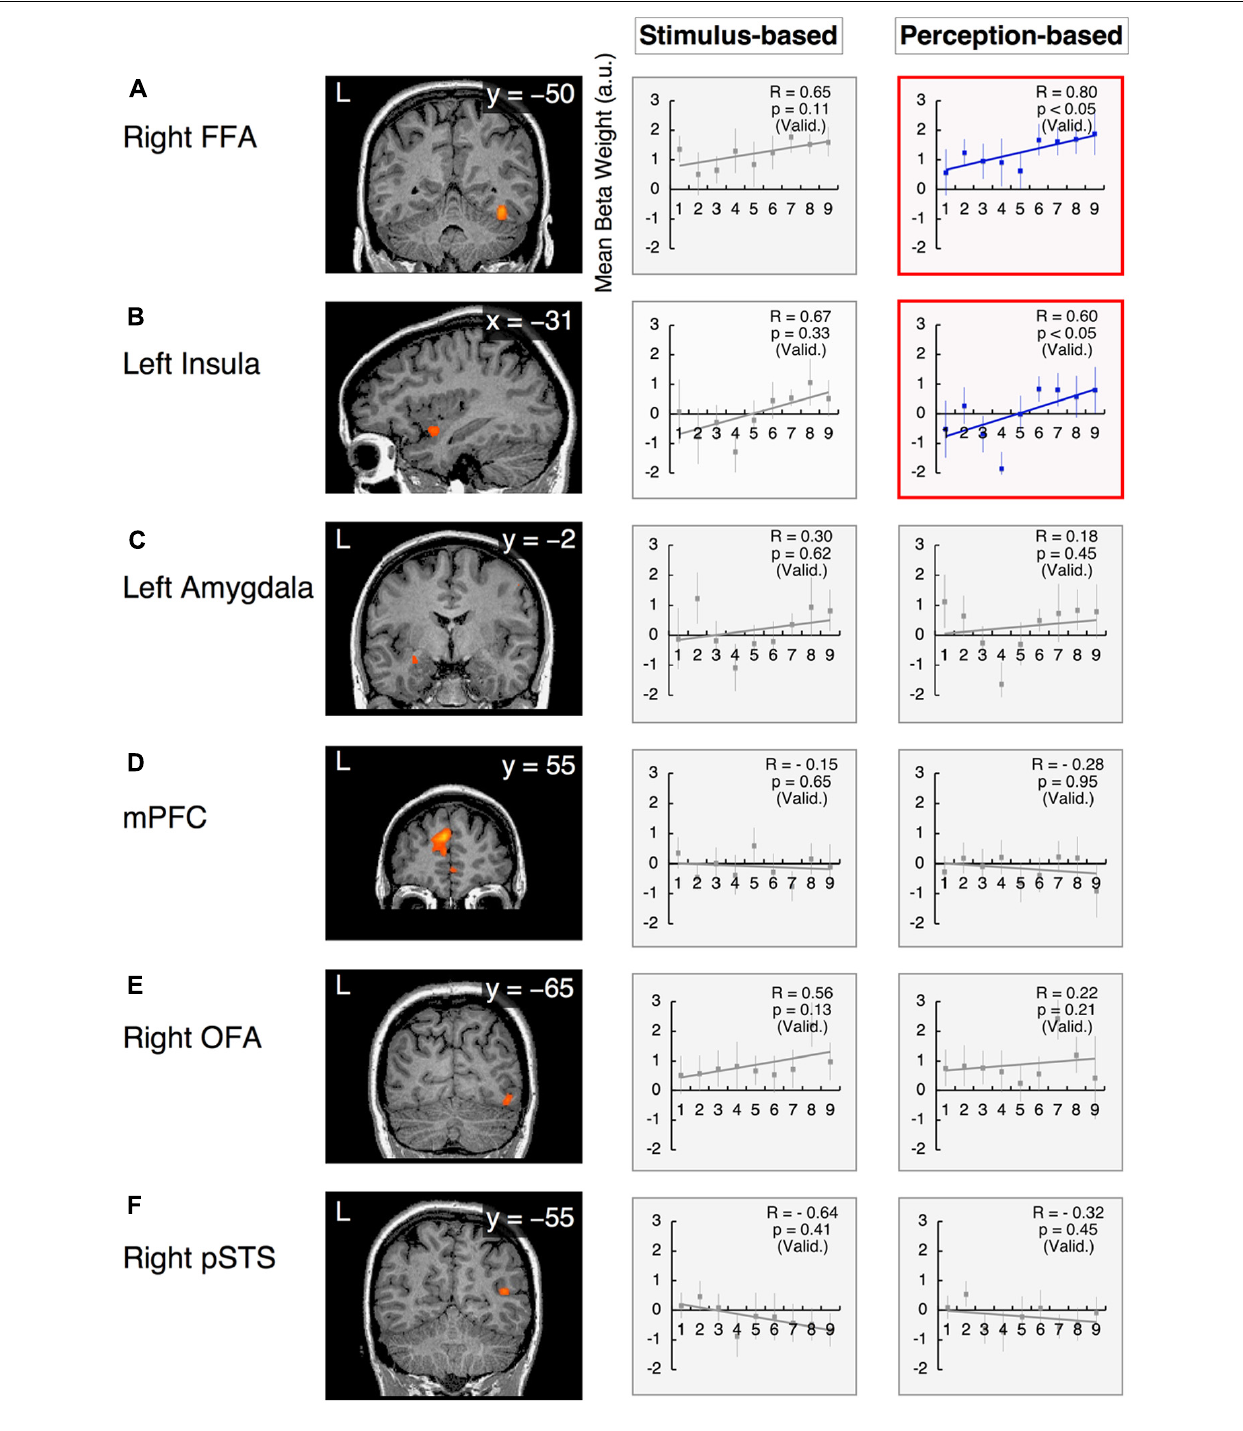
FIGURE 7 | Functional magnetic resonance imaging results in the arousal dimension. The x -values represent morphed faces on the anger–disgust continuum depicted in Figure 2B , ranging from “1” = “0% anger” to “9” = “100% anger.” The y -axes represent the BOLD signals [with arbitrary units (a.u.)]. Two graphs are provided for each ROI to indicate the results from the stimulus-based and perception-based analyses. Graphs in red squares represent dimensional (linear) processing